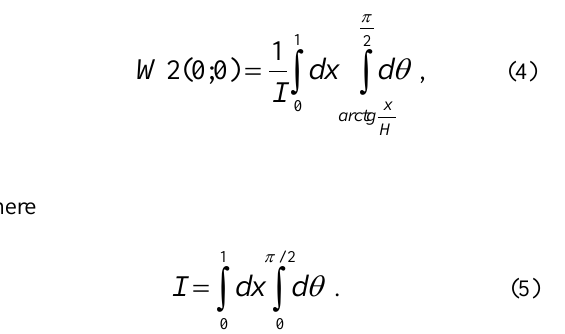
Table 4. Densities of probability distributions of collisions of atoms over the height of the system